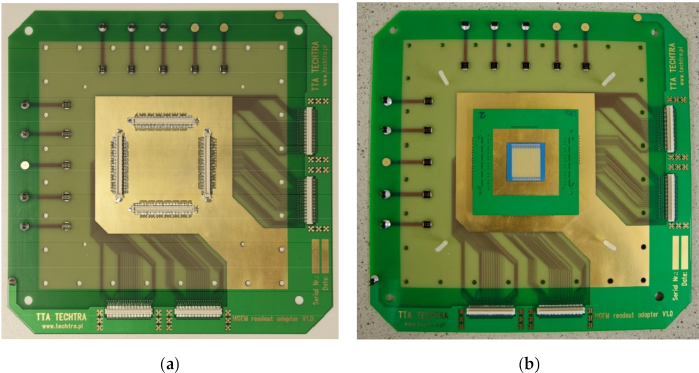
Figure 6. The PCB setup for ceramic readouts testing, ( a ) board with connectors; ( b ) board with connected LTCC readout module.